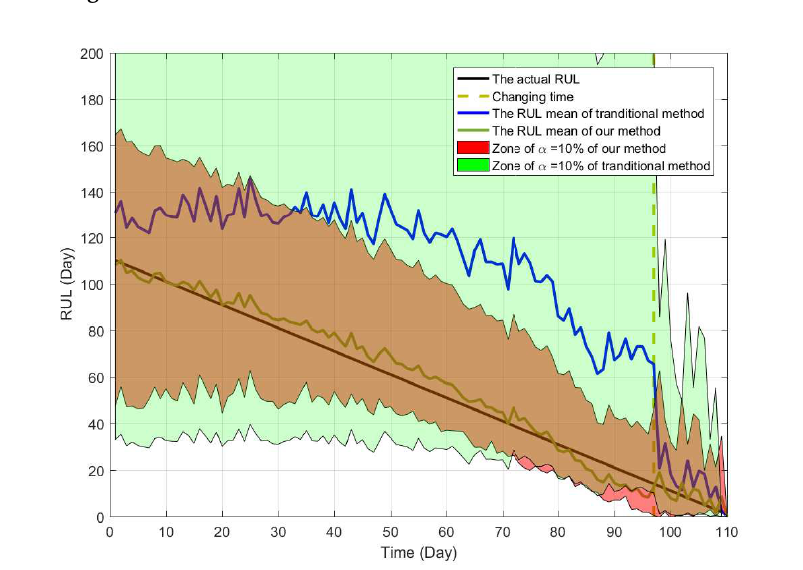
Figure 8. The estimated RUL based on our method at different time.